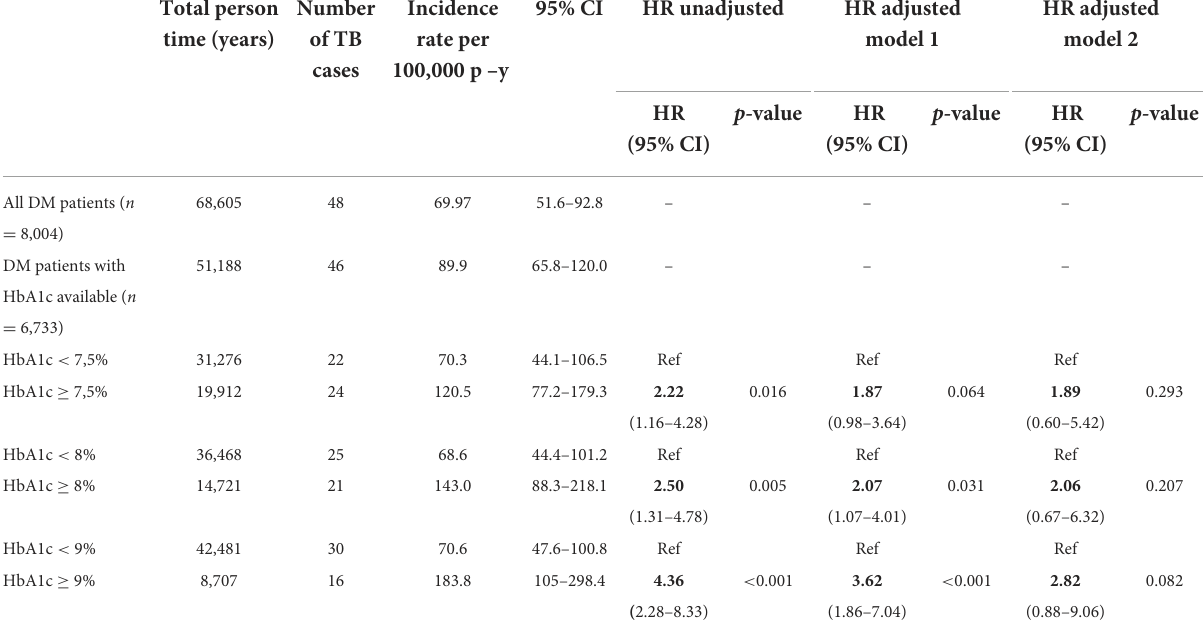
TABLE 3 Incidence and risk of TB (unadjusted and adjusted hazard ratio) in DM patients depending on HbA1c level (%).